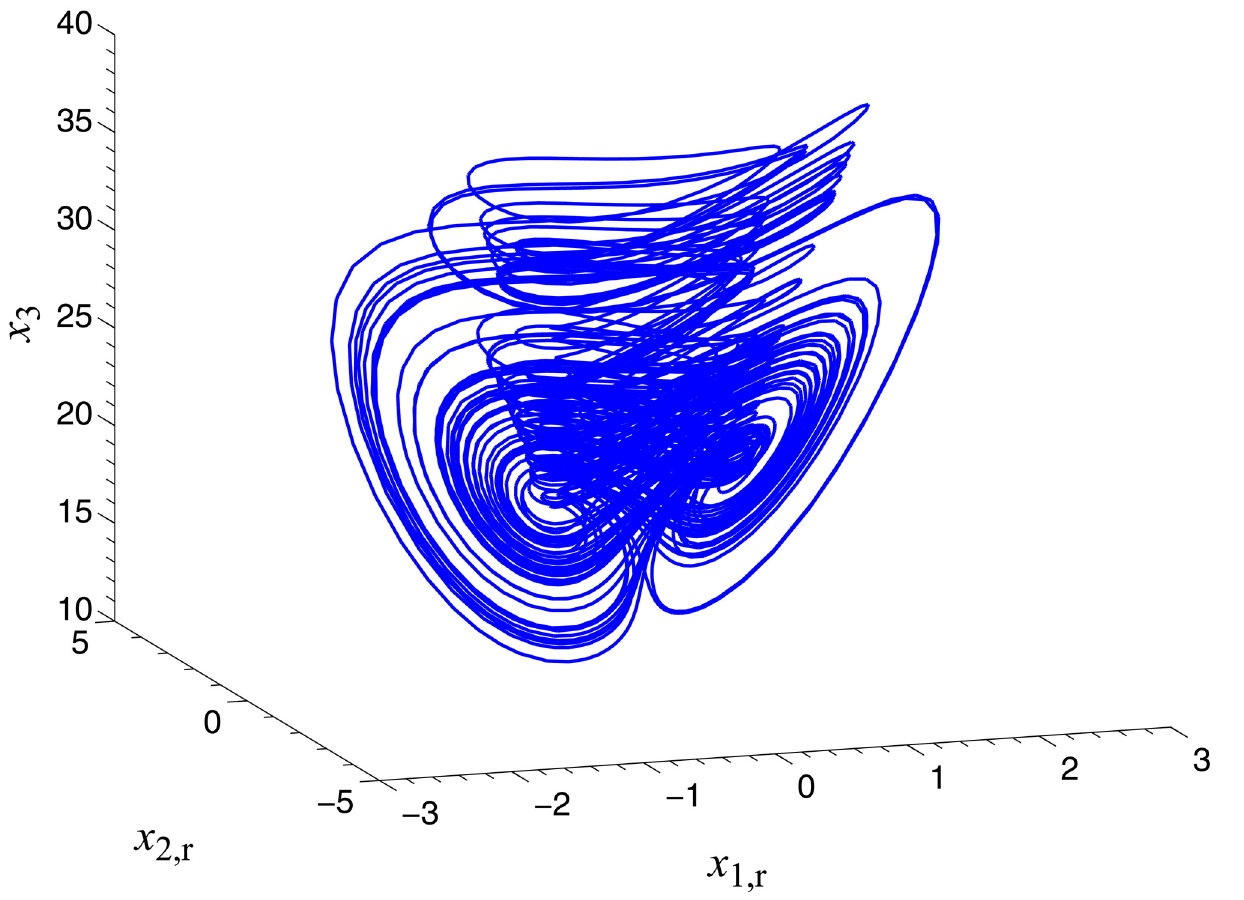
Fig 6. Chaotic attractor of the complex Chen